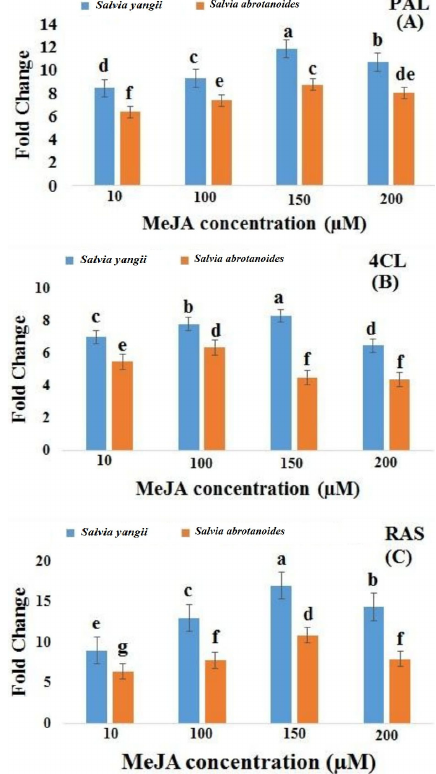
Figure 4. The relative expression of PAL ( A ), 4CL ( B ), and RAS ( C ) genes in the control and MeJA-treated Salvia plants (fold-changed). Duncan’s test indicates a statistically significant ( p ≤ 0.01) difference between bars labeled with different letters. Error bars depict the standard error values. Means followed by the same letters in each column are not significantly different ( p < 0.01).